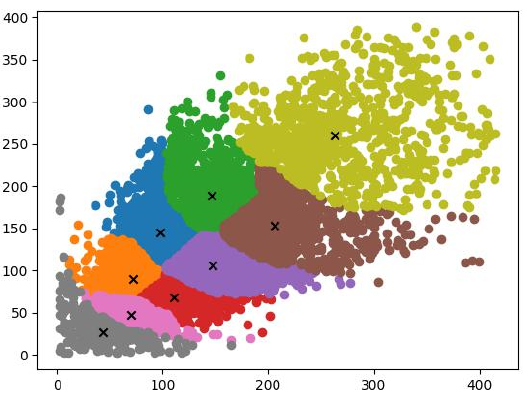
Figure 10. Generation of nine candidate boxes by K-means (K =